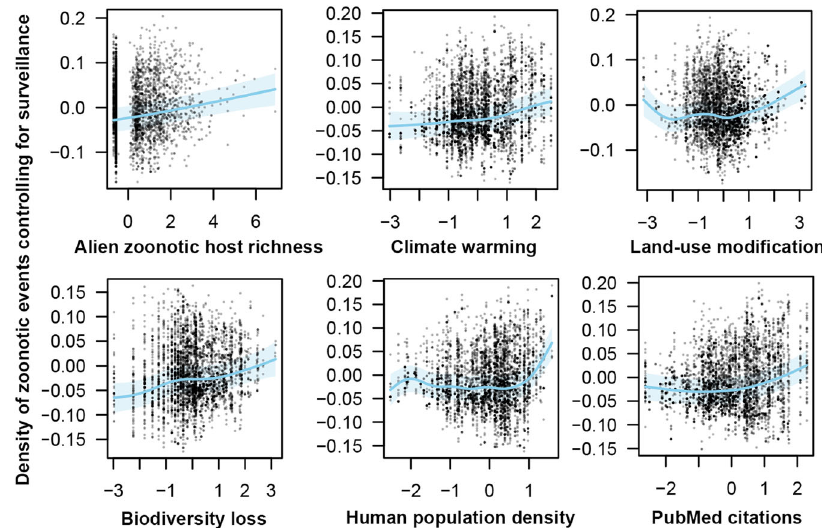
Fig. 4 Relationships of the six most important predictor variables with zoonosis emergences in the fi ve highly supported models. Scatter plots represent the partial residuals of each smoothed variable when controlling for other variables. Blue lines show the predicted function of each variable with mean and the shaded area as the 95% con fi dence band based on GAMMs. The dependent variable (zoonosis event density) is treated as the residuals of the fi tted regression correlating the density of zoonosis events and the density of all disease events to account for the degree of overall disease surveillance (Supplementary Data 4). All predictor variables were standardized (to a mean of zero and standard deviation of one) before entering the